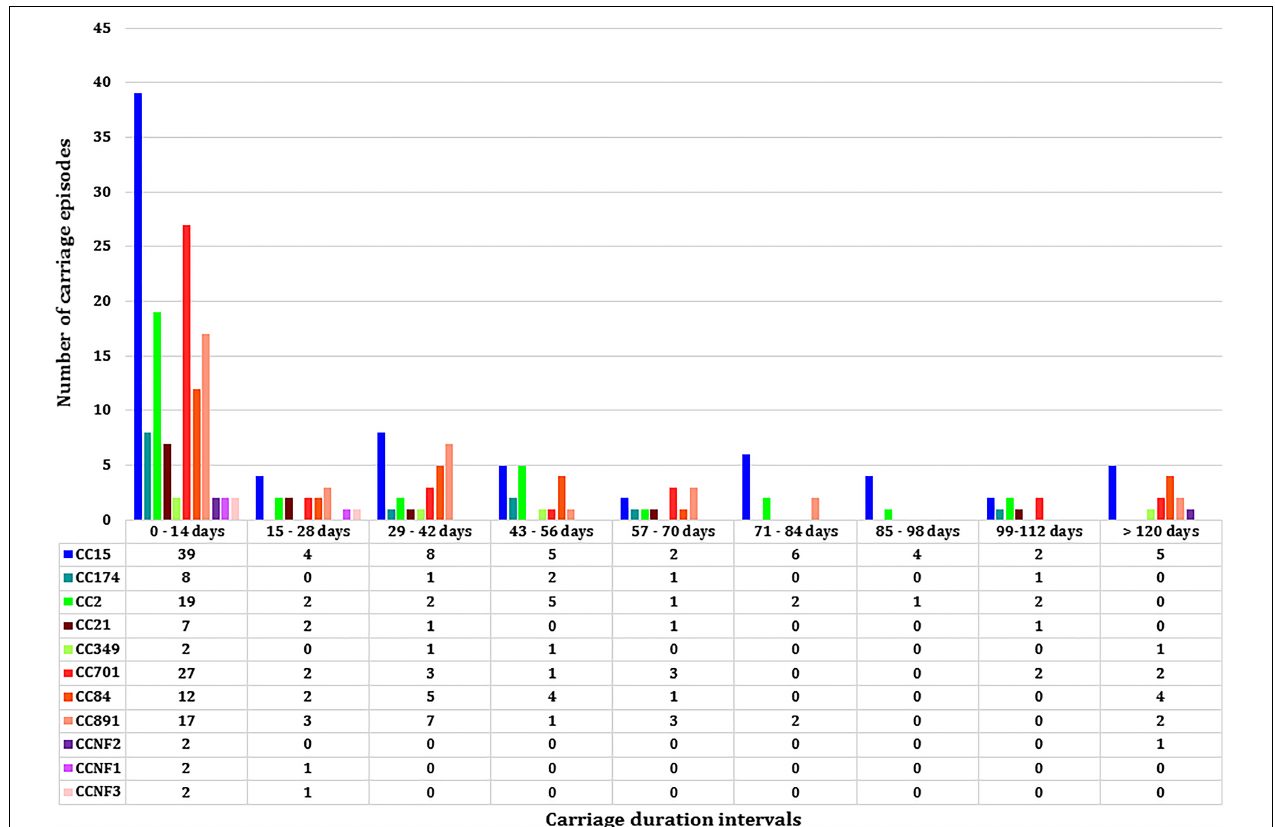
FIGURE 3 | The median carriage duration of different genotypes ( spa -clonal complexes, CC) stratified by different intervals of carriage.